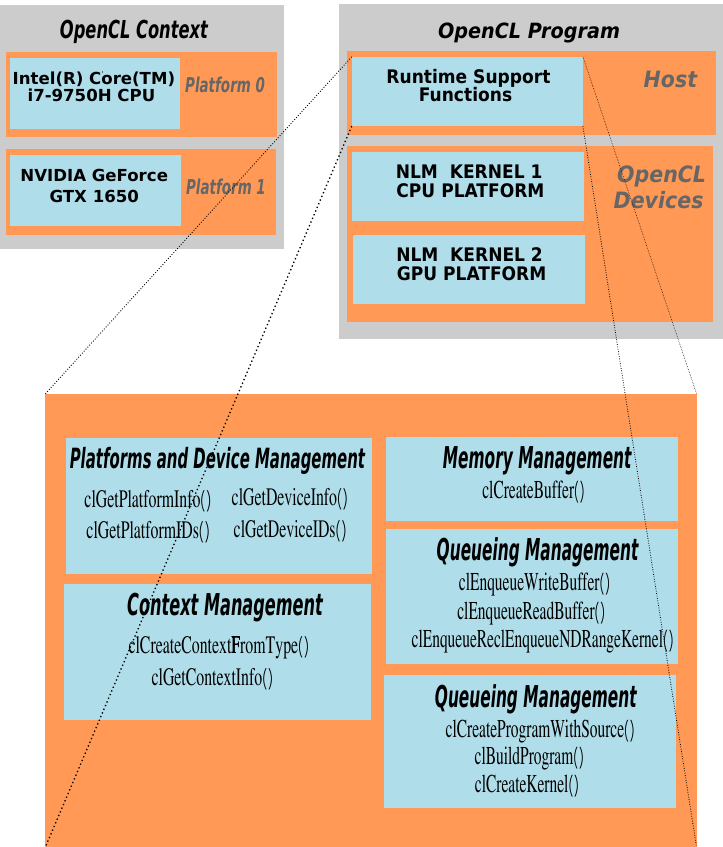
Figure 1. Open Computing Language (OpenCL) runtime functions supporting the parallel execution of NonLocal Means (NLM) kernel using threaded